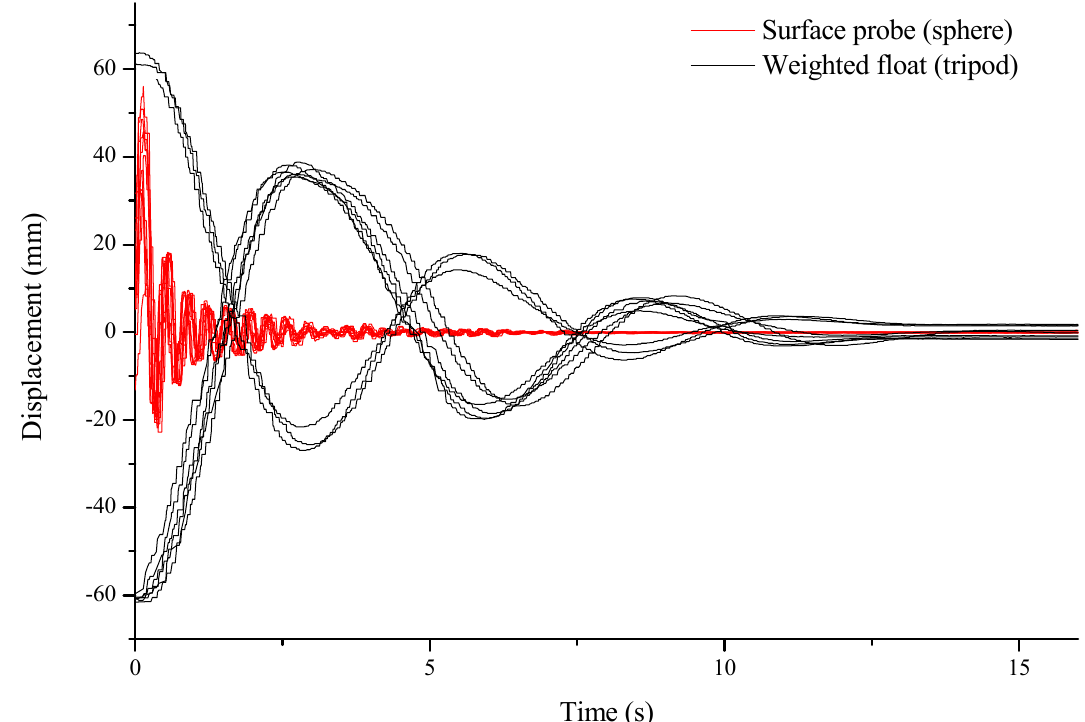
Figure 4. Transient responses of the displacement readings of the two probes, when subjected in laboratory to repeated forced immersions and subsequent release. Note the hysteresis in the equilibrium points of the tripod weighted